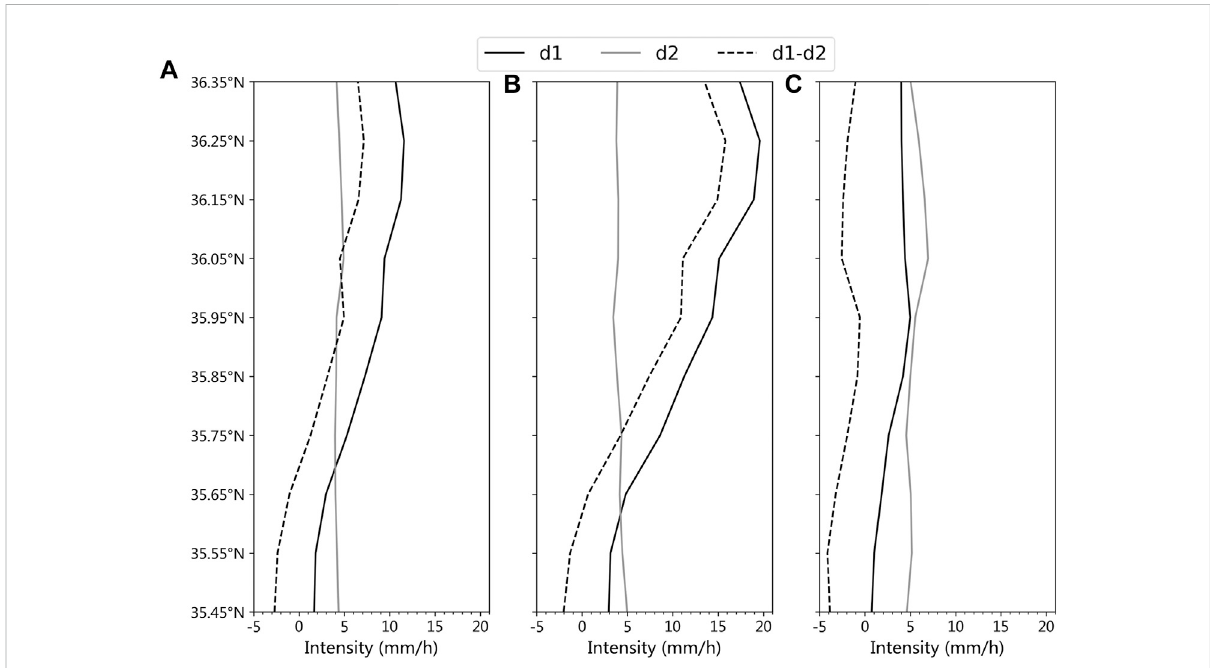
FIGURE 3 Hourly mean precipitation intensity in areas D1 and D2 indicated in Figure 2A and the difference between the two areas from (A) 0000 UTC on July 19 to 0000 UTC on July 20, (B) 0000 UTC on July 19 to 1200 UTC on July 19, and (C) 1200 UTC on July 19 to 0000 UTC on July 20.